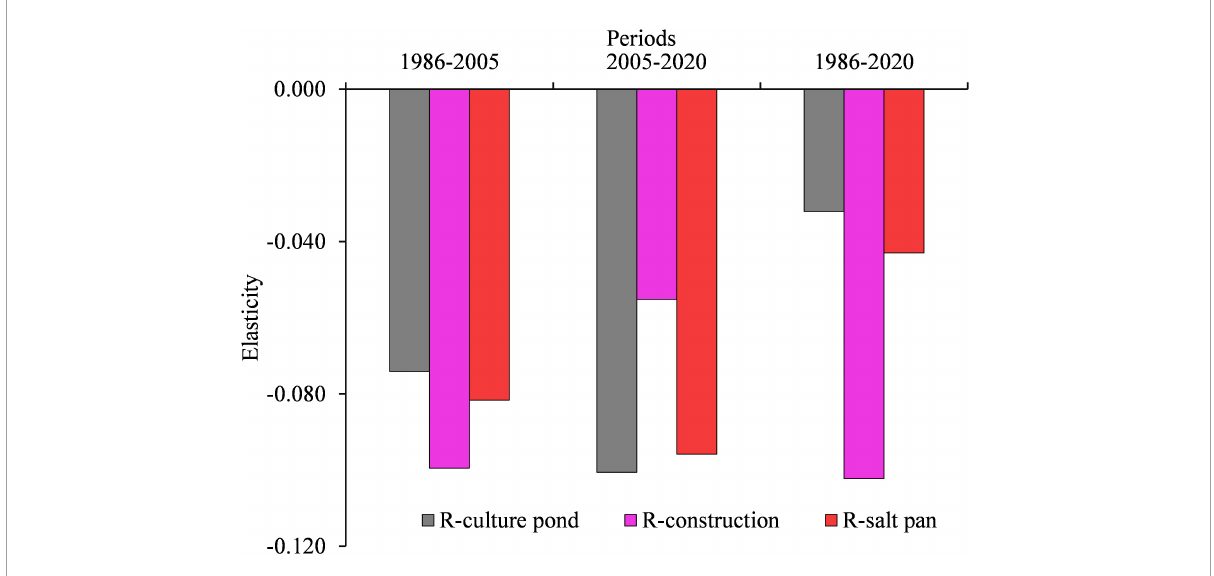
FIGURE11 The reclamation activities elasticity of habitat